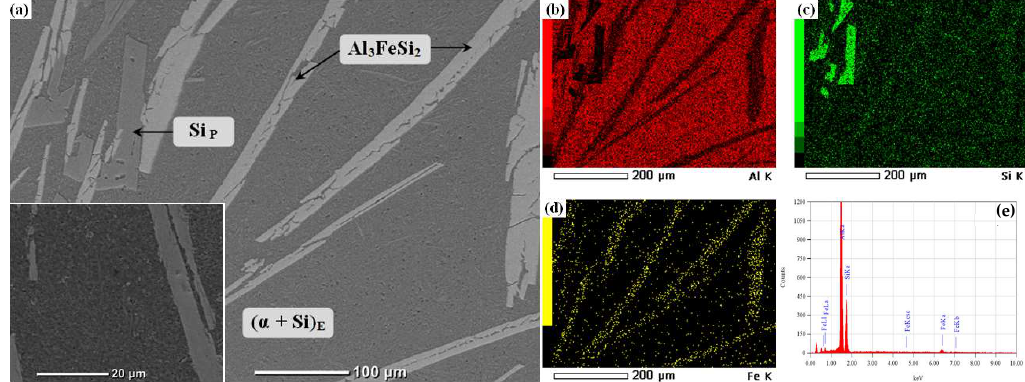
Figure 1. ( a ) Backscattered electron image of the Al–20Si–5Fe master alloy, eutectic microstructure as insert. Elemental mapping of ( b ) aluminum, ( c ) silicon, ( d ) iron, and ( e ) Energy Dispersive X–ray Spectroscopy pattern. Si p = Primary silicon, ( α +Si) E =